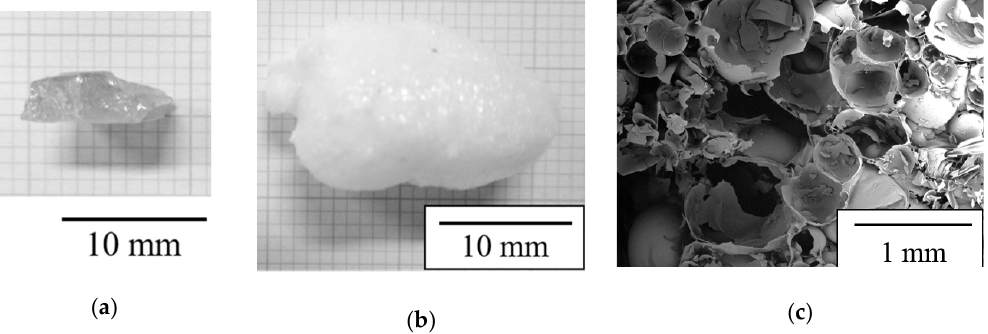
Figure 1. ( a ) Appearance of H 2 O-bearing glass after hydrothermal reaction. ( b ) Appearance of porous glass obtained by reheating the H 2 O-bearing glass. ( c ) Cross-sectional SEM image of microstructure of porous glass.